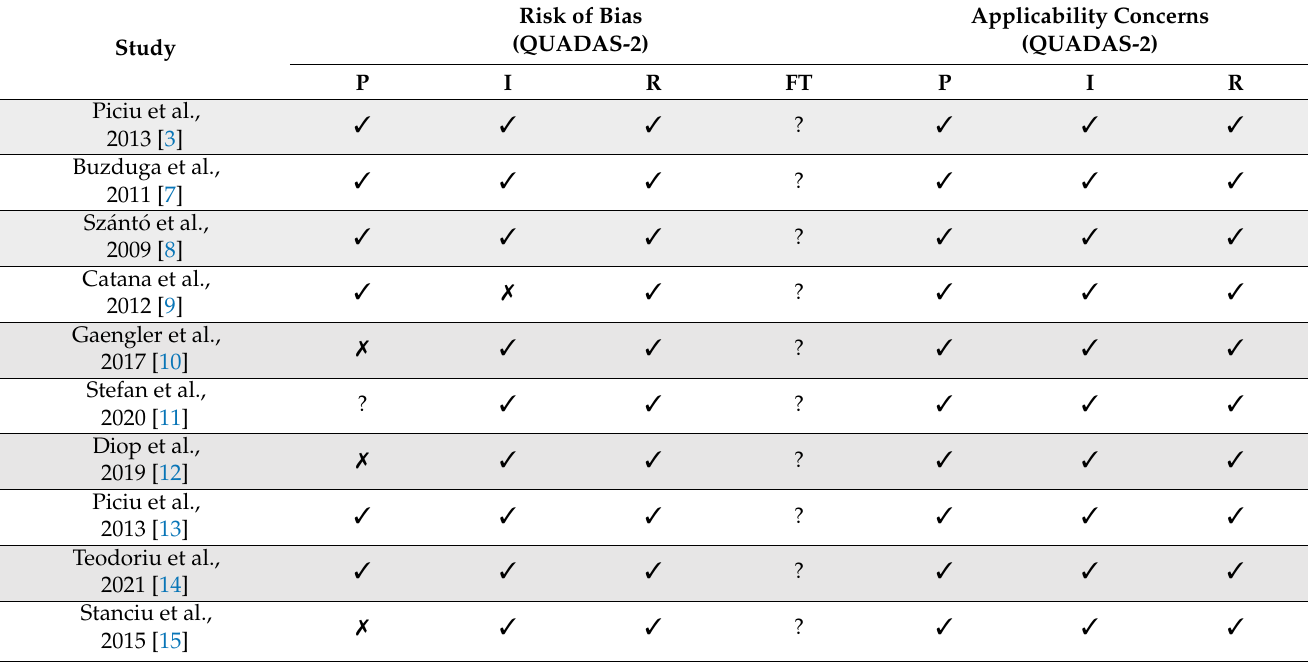
Table 5. A summary of quality assessment of the included studies: